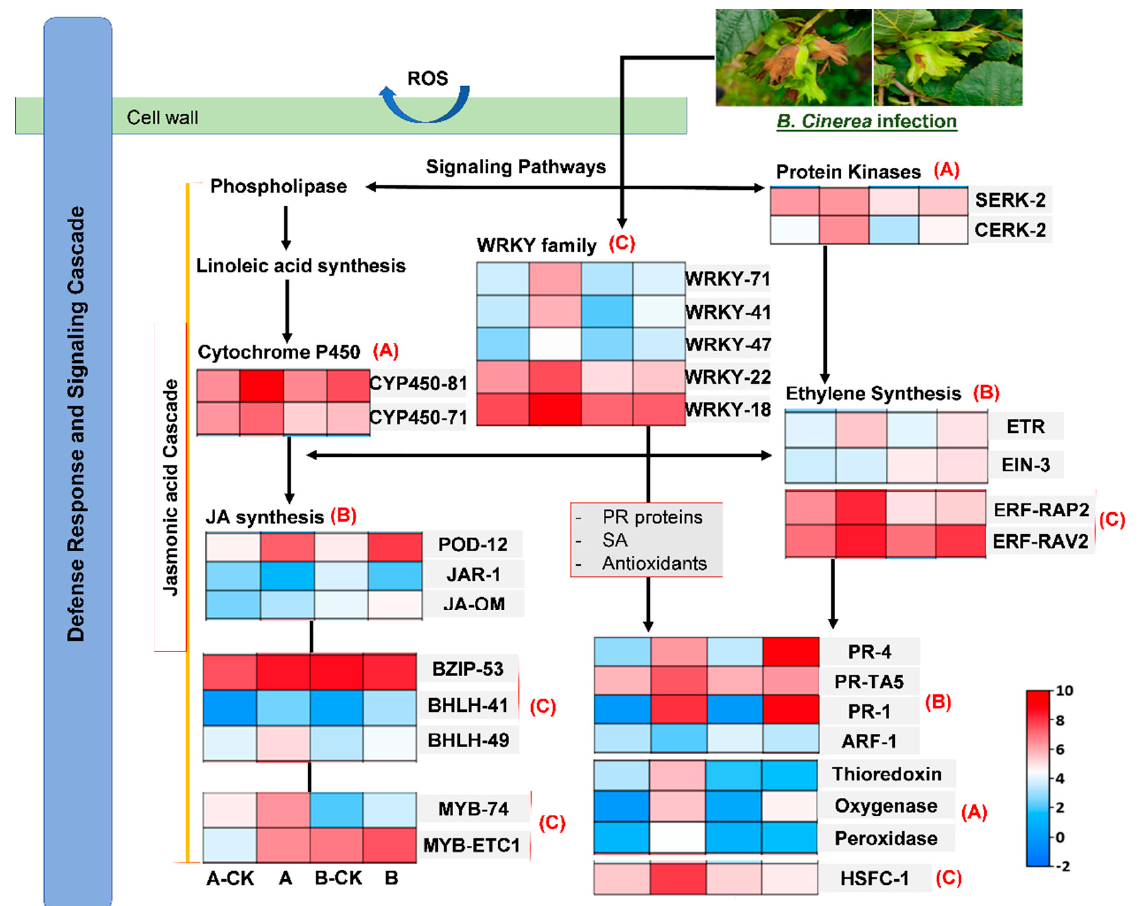
Figure 5. Expression profile of potential key genes partaking in resistance of hazelnut plant against B. cinerea infection. Heatmaps were generated with LOG2 transformation of FPKM values for each treatment through TB-tool software. ( A ) expression changes of genes involve in oxidoreductase pathway, ( B ) expression changes of genes involve in Phytohormone and signaling pathway and ( C ) expression changes in key TFs. Treatments: A-CK (Dawei-un-inoculated control), A (Dawei- inoculated with B. cinerea ), B-CK (Qiuxiang-un-inoculated control), B (Qiuxiang- inoculated with B. cinerea ).